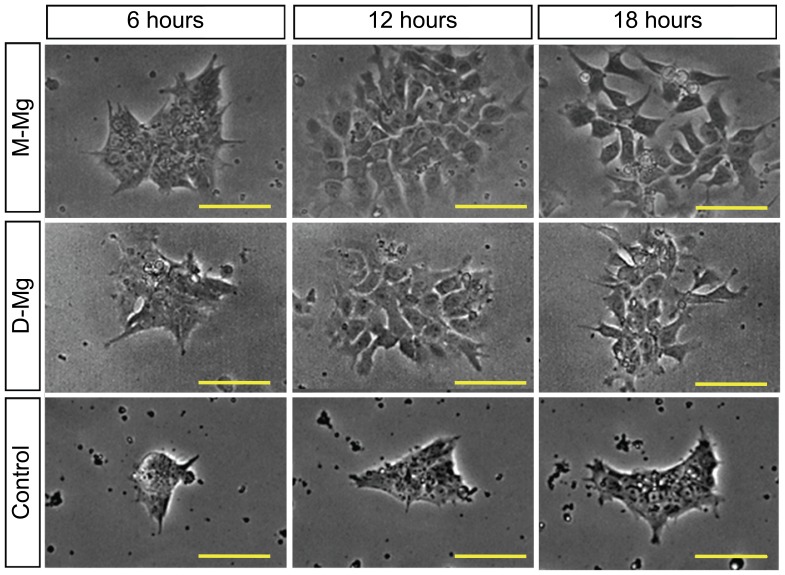
Phase contrast optical images of hESC colonies cultured with M-Mg and D-Mg.As compared with the control, the H9-OCT4 hESCs exposed to the M-Mg and D-Mg showed increased dispersion at 12 and 18 hours of culture, and thus greater coverage area of cell colonies. Scale bar = 100 µm.